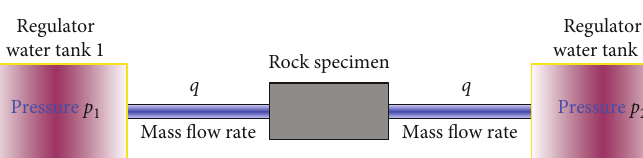
Figure 4: Mechanical model of the transient permeation experimental